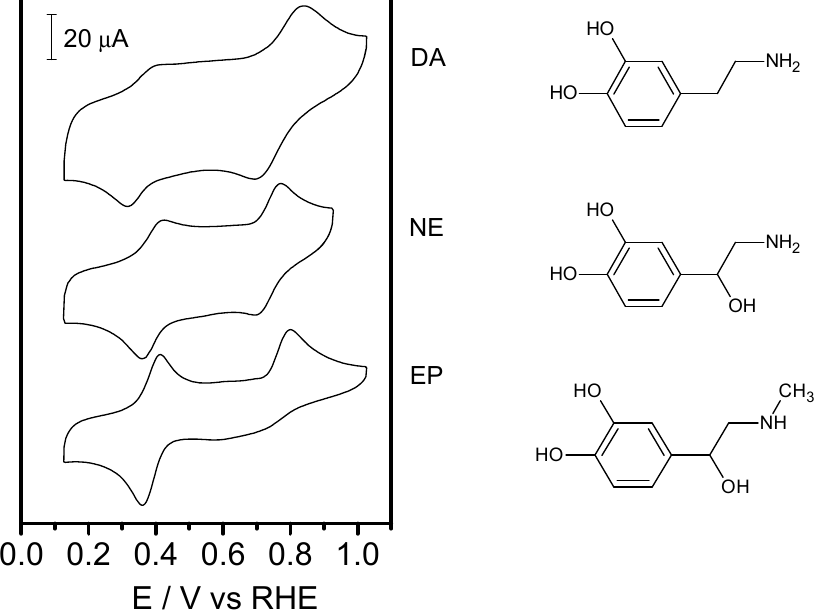
Figure 4. Stabilized cyclic voltammograms for a glassy carbon electrode immersed in in phosphate buffer solution (PBS) solutions (pH 7) containing 1 mM neurotransmitter: dopamine (DA), norepinephrine (NE), and epinephrine (EP). Scan rate 100 mVs − 1